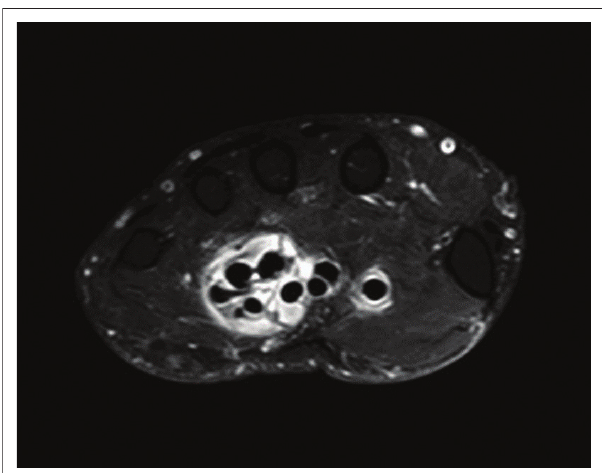
FIGURE 6: Axial proton density-weighted fat-saturated post-contrast magnetic resonance imaging at the level of the metacarpal bones demonstrating enhancement of the flexor tendons within the flexor compartment in keeping with tenosynovitis.